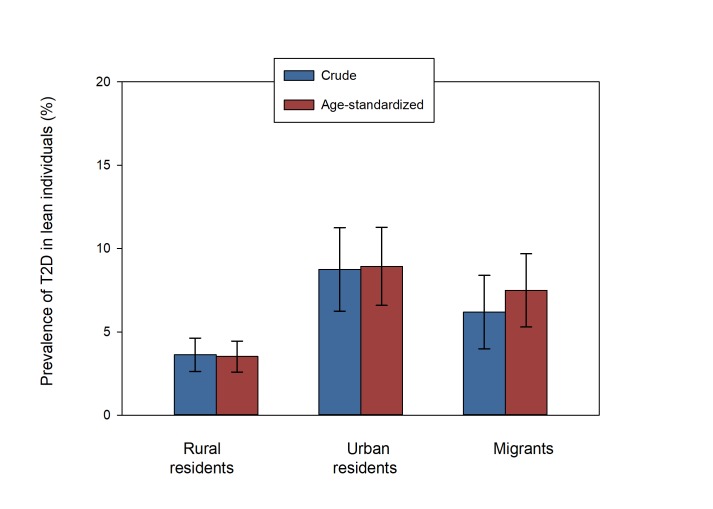
Crude and age -standardized prevalence of type 2 diabetes in underweight/normal weight urban residents, rural residents and migrants. Age-standardized prevalence of type 2 diabetes in underweight/ normal weight participants includes confidence intervals as follows; rural residents 3.52% (95% CI = 2.29-4.45), urban residents 8.93% (95% CI = 6.59-11.27), migrants 7.49% (95% CI = 4.89-6.85). T2D – type 2 diabetes mellitus.